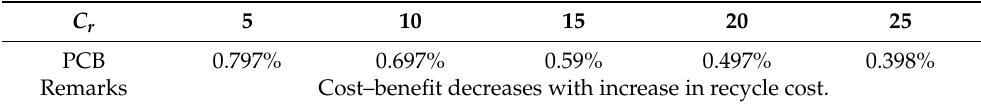
Table 5. Sensitivity of “recycle cost” to cost–benefit. The static input values of the parameters are: